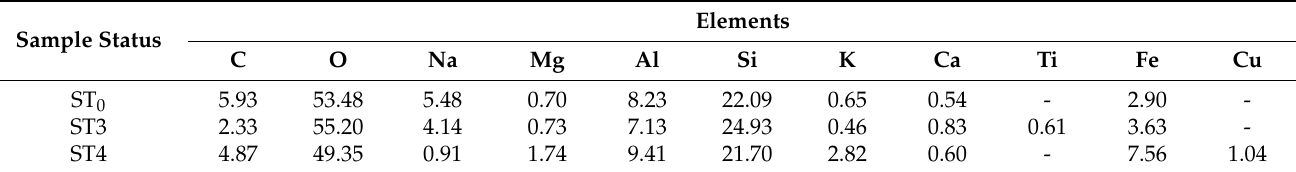
Table 2. Weight % of elements in the studied samples ST 0 –ST